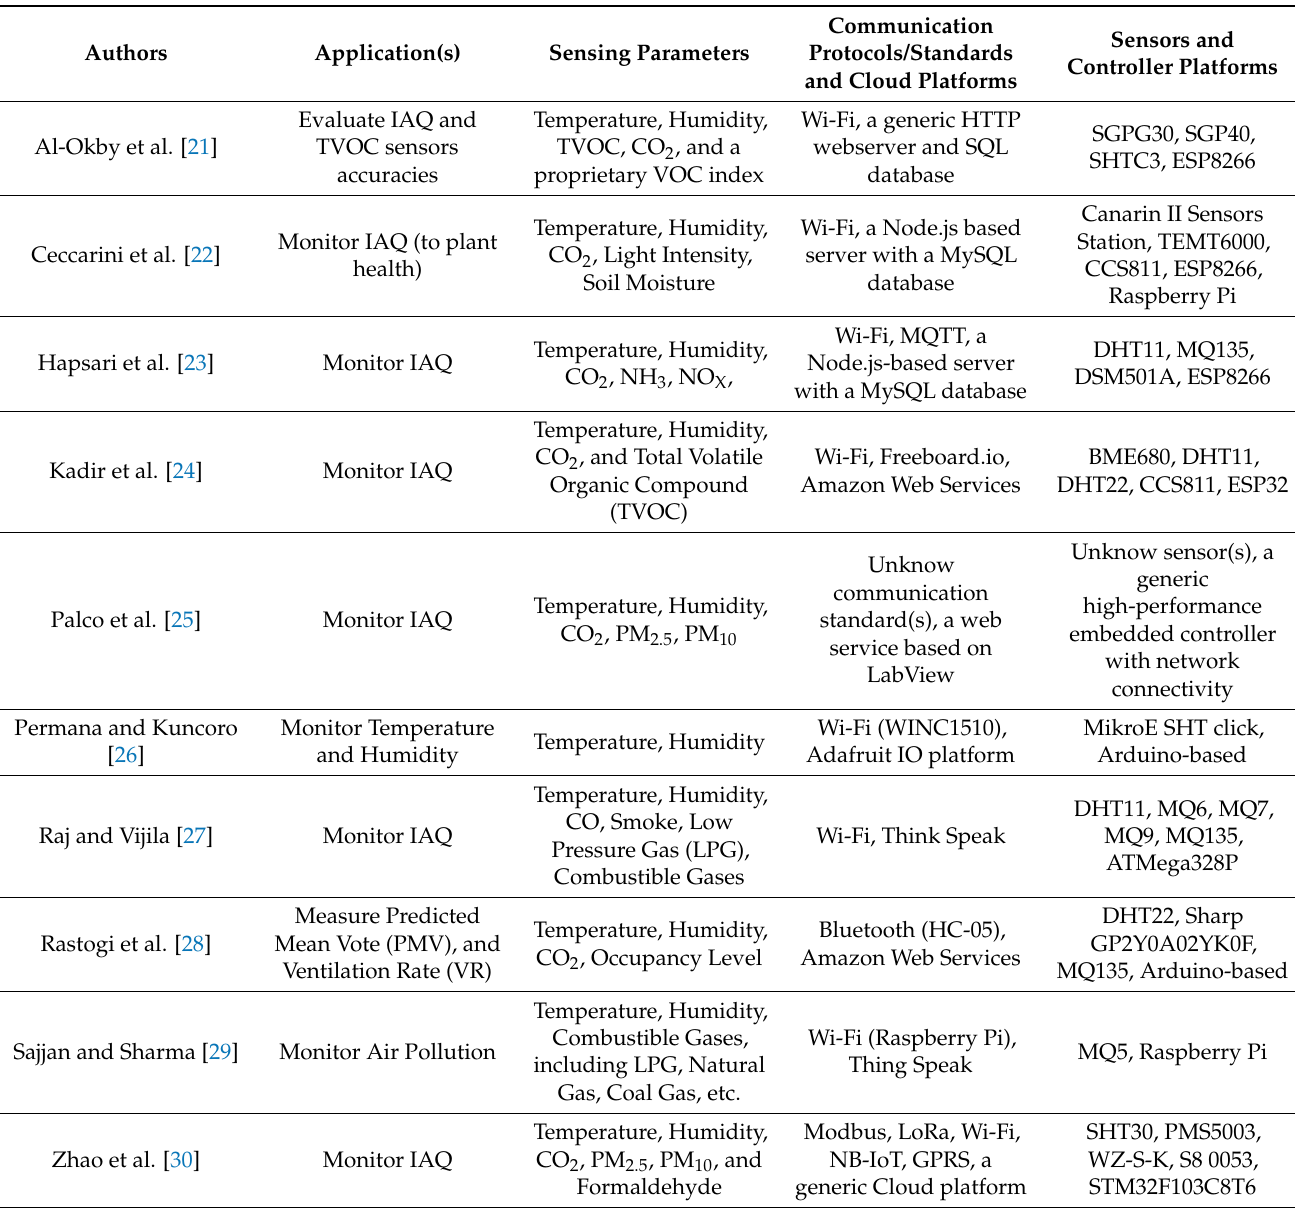
Table 2. IAQ studies with the used of IoT